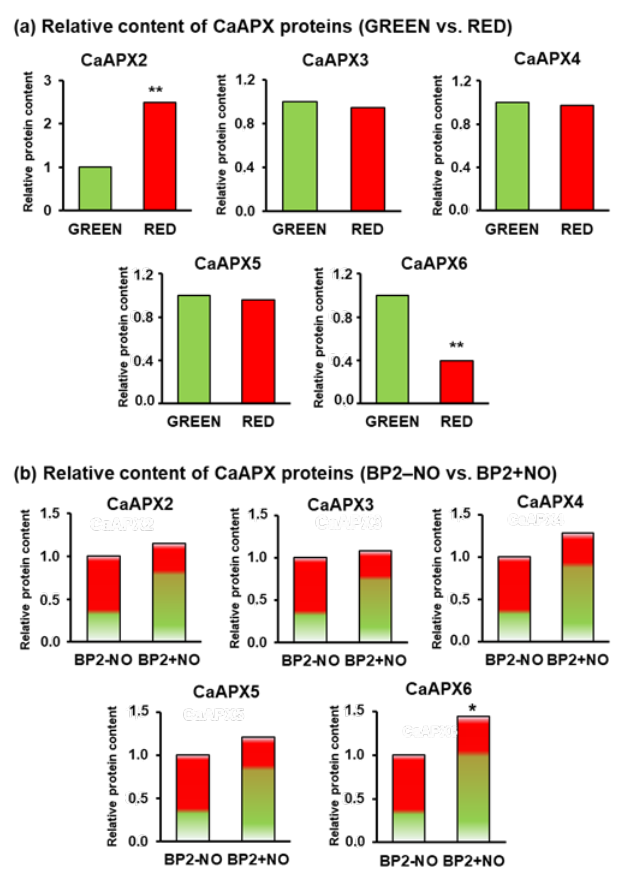
Figure 4. Time course protein expression analysis of five CaAPX isozymes identified by iTRAQ. ( a ) Comparative protein expression of CaAPX isozymes between pepper fruit at green and ripe red stages. ( b ) Comparative protein expression of CaAPX isozymes of pepper fruits, at breaking points, treated or untreated with NO. Samples of sweet pepper fruits at different ripening stages correspond to immature green, ripe red, and breaking point 2 with and without NO treatment (BP2 + NO and BP2 − NO, respectively). Asterisks indicate that differences between values were statistically significant at p < 0.05.